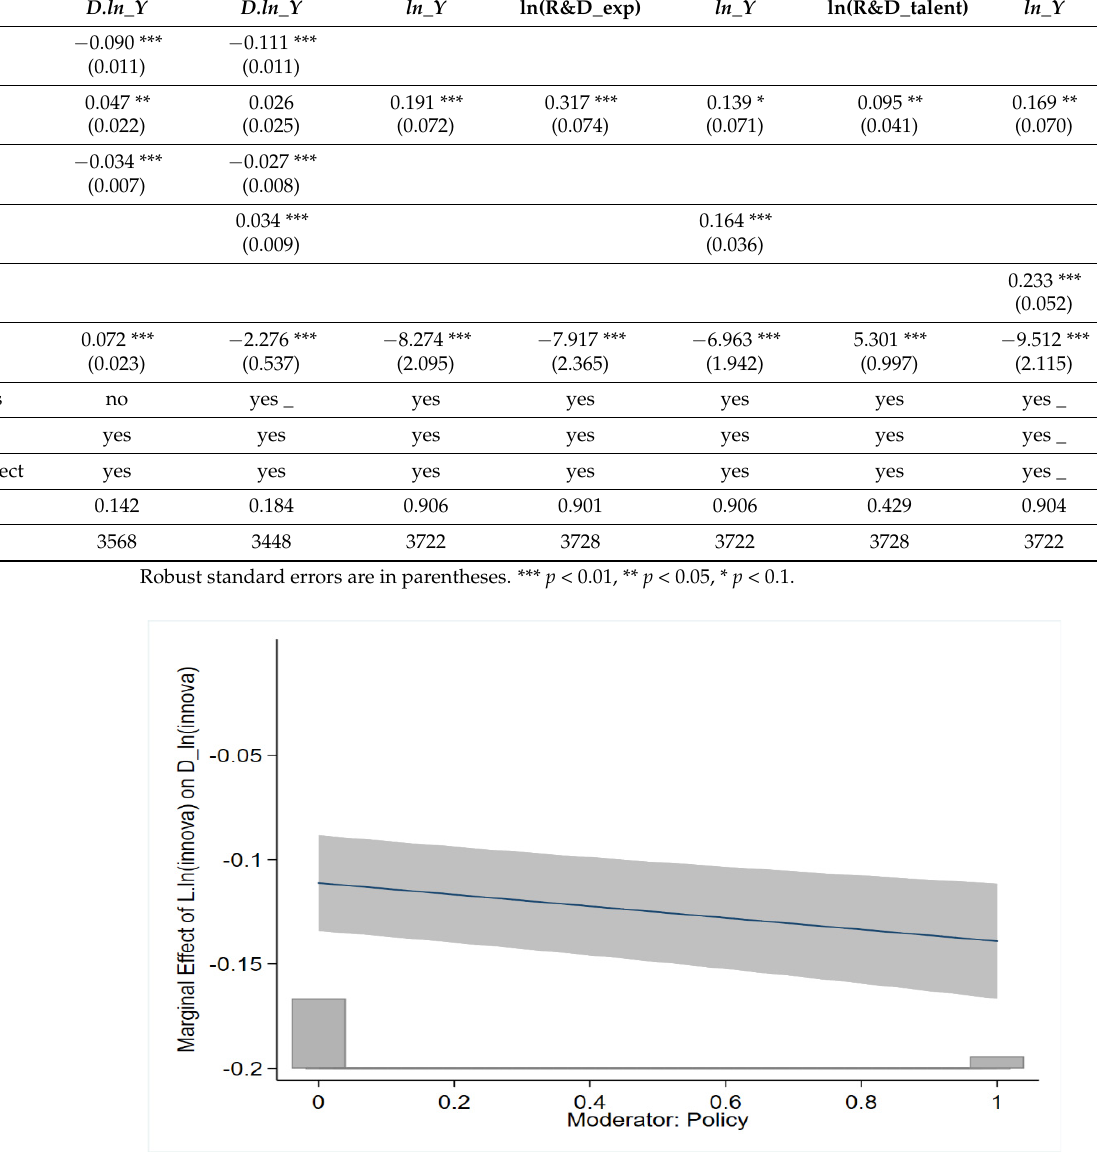
Table 2. Results of moderating and mediating effects.